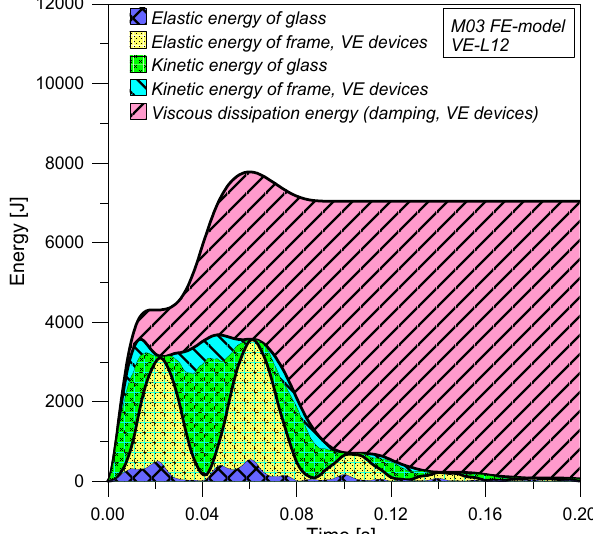
Figure 19. Energy balance for the curtain wall equipped with VE